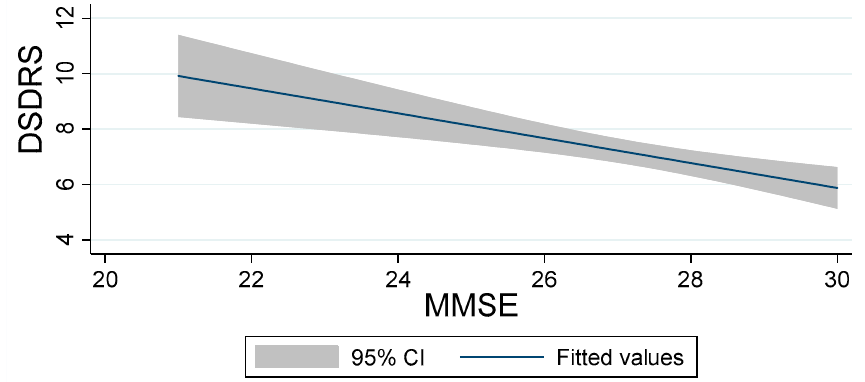
Figure 1. Correlation between DSDRS and MMSE scores. DSDRS: diabetes specific dementia risk score, MMSE: Mini-Mental State Examination.